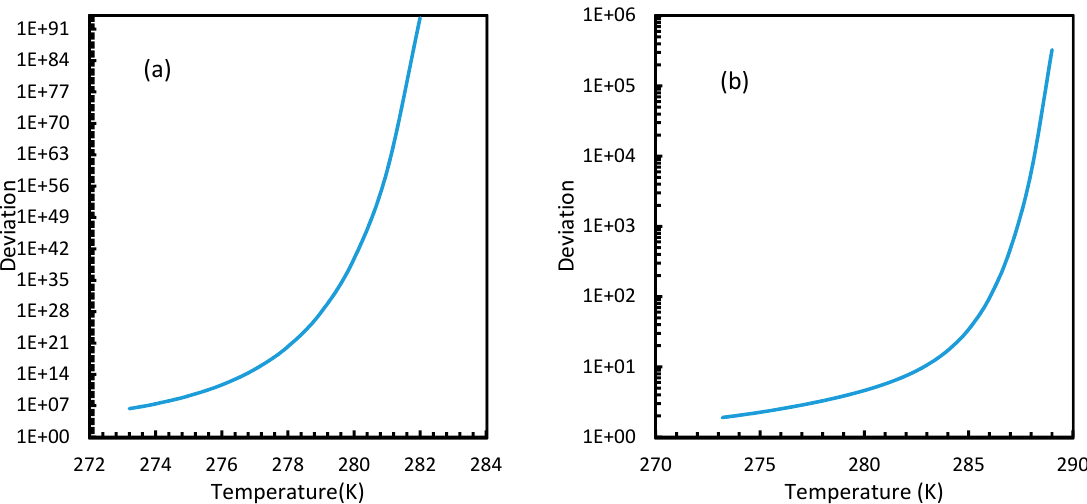
Figure 12. Profiles of deviations of nucleation rates of CO 2 ( a ) and CH 4 ( b ) under isobaric conditions